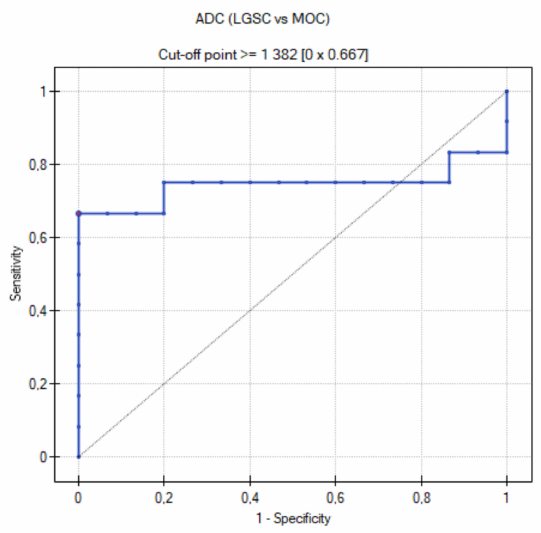
Figure 11. ROC curve for diagnostic performance of the ADC parameter in detection of EOC (LGSC vs.